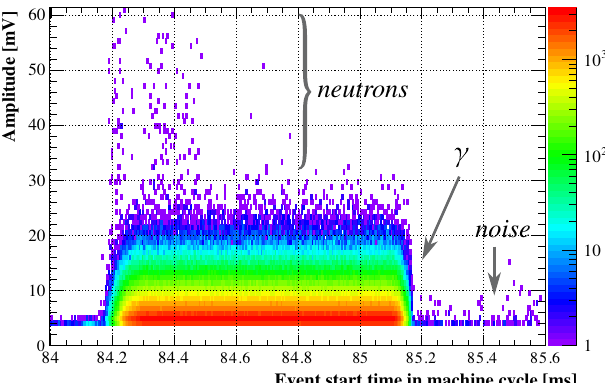
FIG. 7. Distribution of reconstructed IEs over amplitude and time inside the LINAC4 machine cycle period for an 8-hour long data